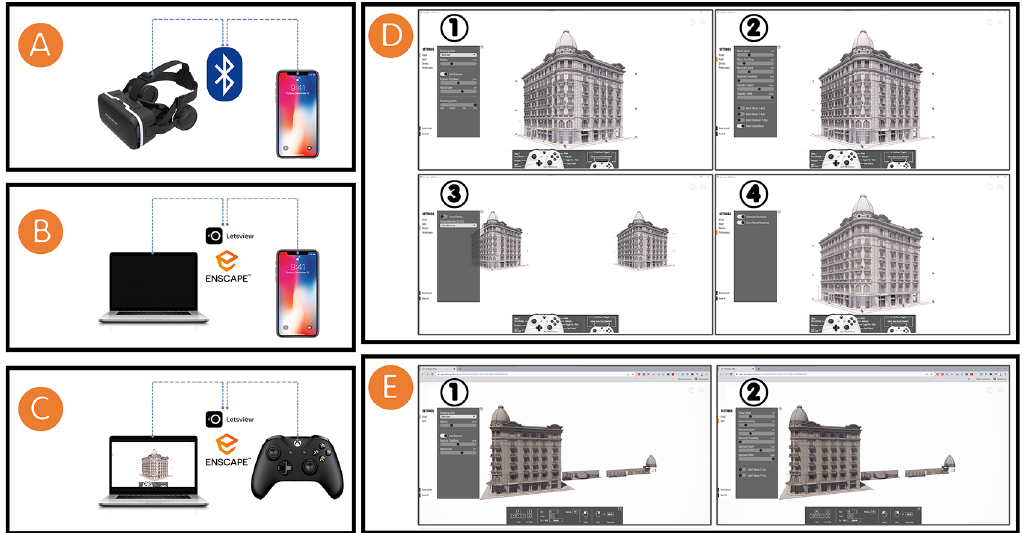
Figure 5. (A) Installing and connecting a smartphone to a Shinecon VR headset SC-G04 through Bluetooth; (B) Mirroring the stream of HBIM model from a PC/laptop to a smartphone through the Letsview platform; (C) Navigating the HBIM model by using Microsoft Xbox One Wireless Controller; (D) Modifying the VR settings for the Société Immobilière building (1) “ Visual, ” (2) “ Input, ” (3) “ Devices, ” and (4) “ Performance ” sub-tabs; (E) Modifying the settings for the Société Immobilière building ’ s website (1) “ Visual, ” and (2) “ Input ” sub-tabs. Thephotos(A),(B),(C),(D),and(E)wereacquiredfromtheresearchers ’ workingontheSociétéImmobilière building by using Enscape3D platform.